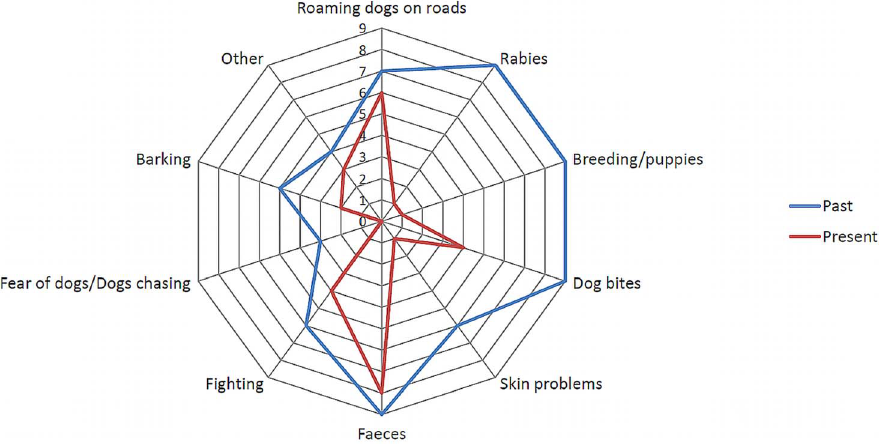
Figure 4. Dog related problems listed in Colombo City, Sri Lanka. The number of focus groups (1 to 9) that listed specific dog related problems perceived for the years 2006 (blue line) and 2011 (red line) in Colombo City, Sri Lanka.